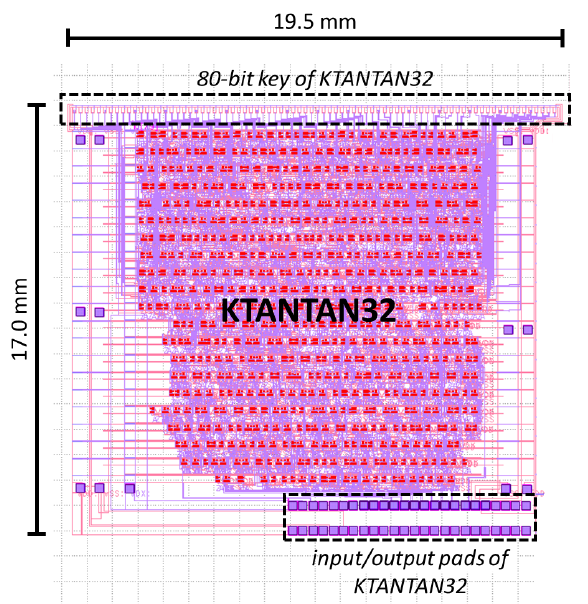
Figure 5: Physical lay-out of the KTANTAN32